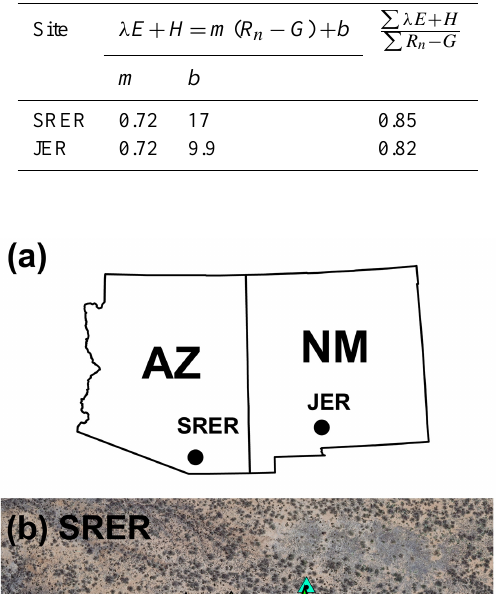
Table 2. Energy balance closure at SRER and JER using 30min net radiation ( R n ), ground ( G ), latent ( λE ), and sensible ( H ) heat fluxes. The parameters m and b are the slope and intercept in the relation λE + H = m(R n − G) + b , while the ratio of the sum of ( λE + H ) to the sum of ( R n – G ) is a measure of how much available energy is accounted for in the turbulent fluxes.